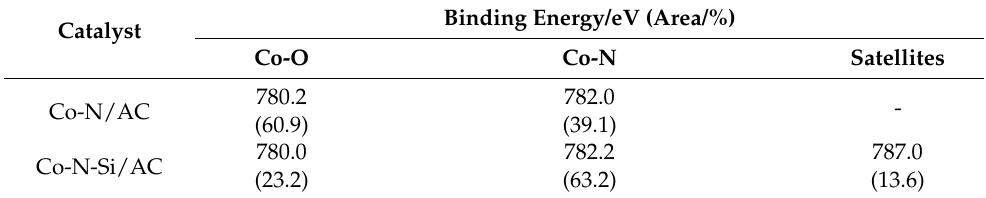
Figure 2. XPS spectra of Co2p in Co-N-Si/AC ( left ) and Co-N/AC ( right ). Table 2. The binding energy and content of Co in the